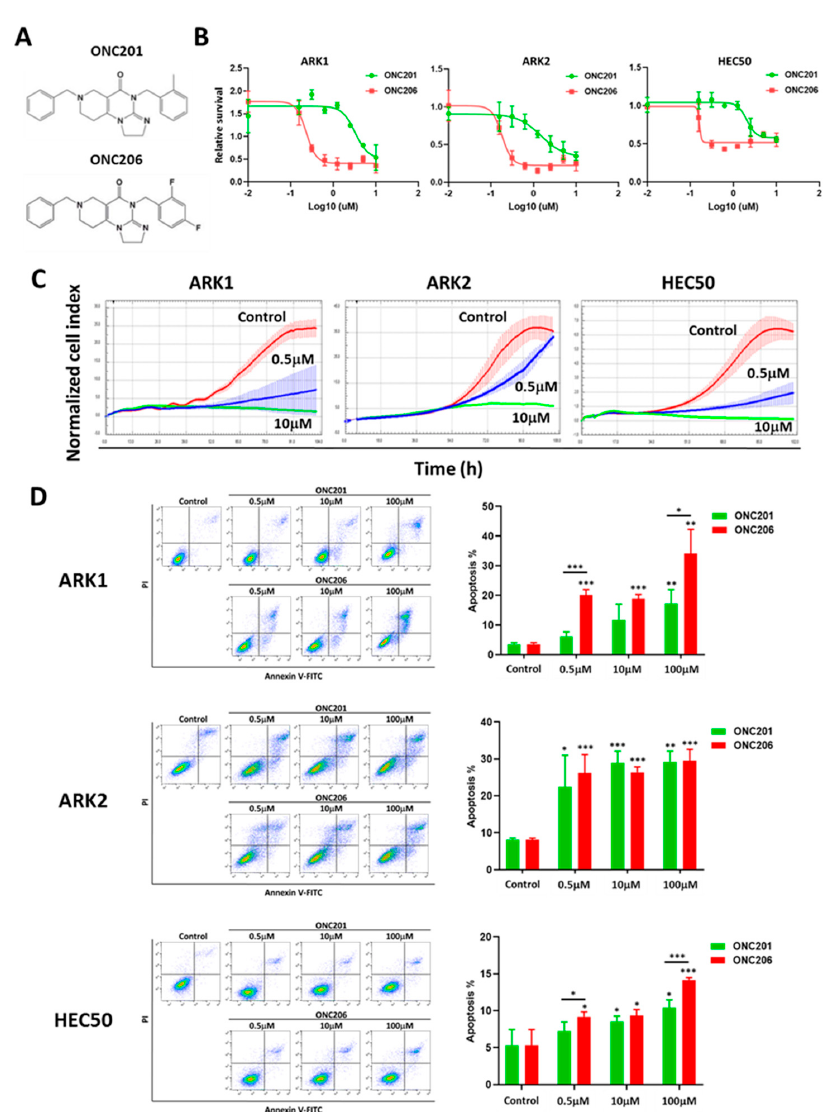
Figure 1. Effect of ONC206 on uterine serous cancer cell viability and apoptosis in vitro. ( A ) Chemical structure of imipridones ONC201 and ONC206. ( B ) ONC201 and ONC206 suppress cell viability of ARK1, ARK2, and HEC50 cells after 72 h of treatment, as measured using the MTT assay. Three independent experiments were performed (mean ± standard deviation). ( C ) ONC201 and ONC206 (0.5 and 10 µ M) suppress cell proliferation of ARK1, ARK2, and HEC50 cells, as measured using the xCELLigence real-time cell analysis assay. ( D ) ONC201 and ONC206 (0.5, 10 and 100 µ M) induce cell apoptosis of ARK1, ARK2, and HEC50 cells after 72 h of treatment, as measured using Annexin V-fluorescein isothiocyanate (FITC) and propidium iodide (PI) staining. Representative images are shown. Results in the bar charts were averaged from three independent experiments and are shown as mean ± standard deviation. *** p < 0.001, ** p < 0.01, * p < 0.05, two-tailed Student t test.